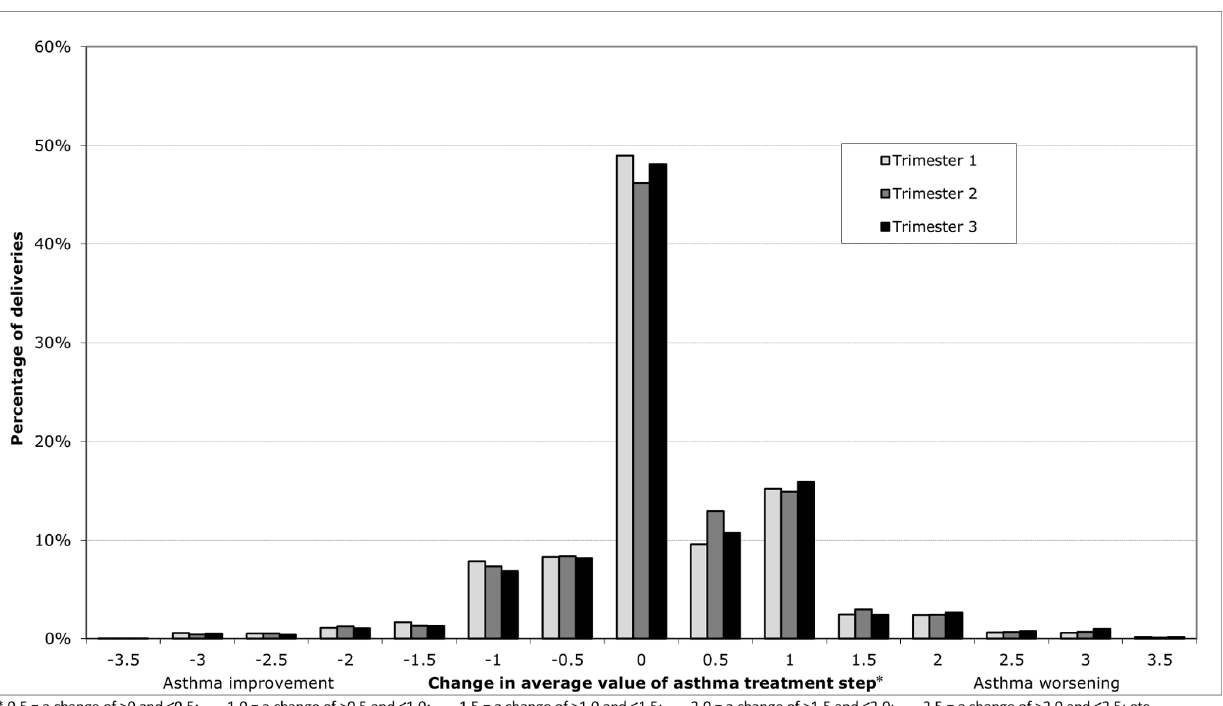
Figure 3. Change in average British Thoracic Society (BTS) asthma treatment step. The percentage of deliveries in which the average BTS asthma treatment step increased, decreased or remained unchanged compared with the calendar period 12 months prior stratified by pregnancy trimester.